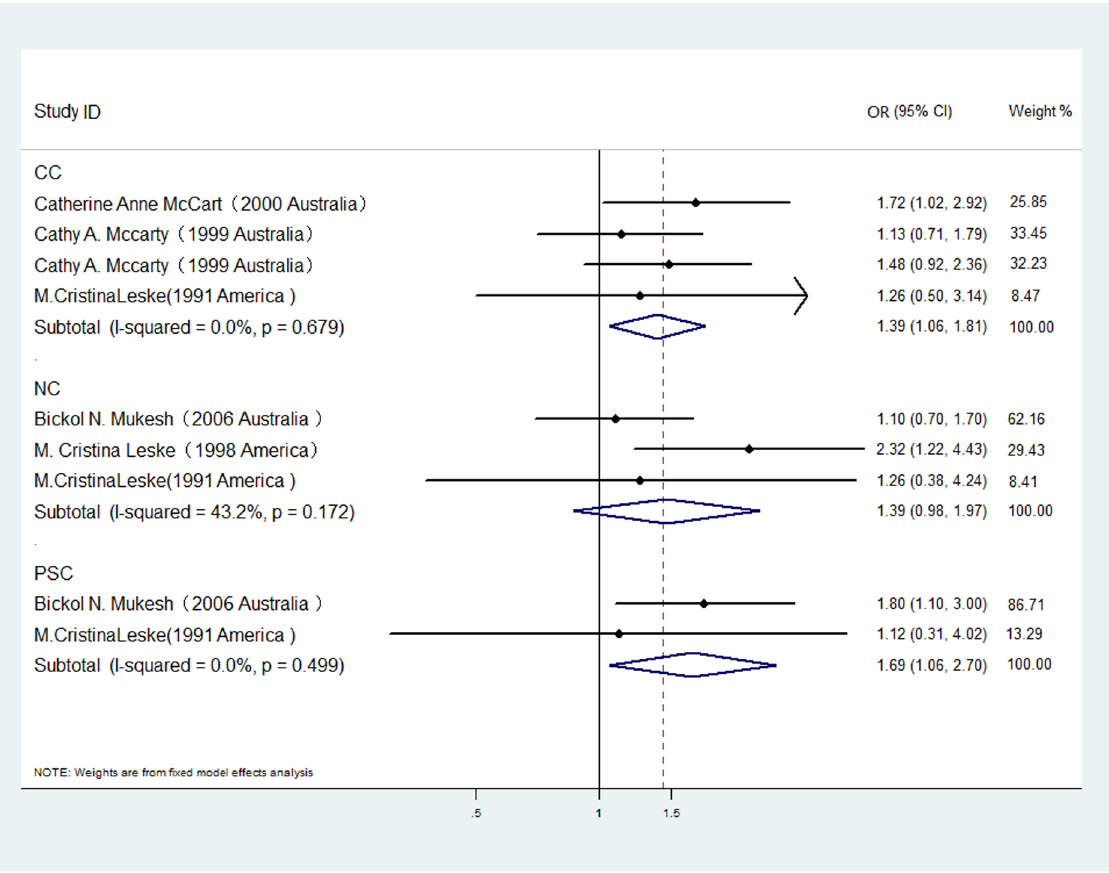
Fig 3. The association of gout with risk of cataract subtypes in case-control/cross-sectional studies.